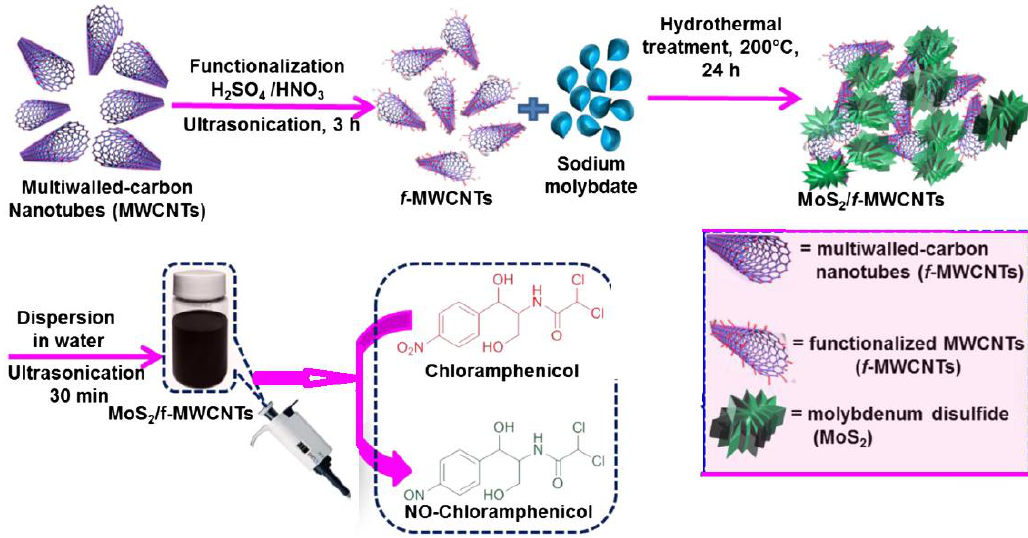
Figure 2. Effect of preparation and functionalization of MoS 2 with MWCNT (reproduced and Figure 2. E ff ect of preparation and functionalization of MoS 2 with MWCNT (reproduced and modified modified from our own publication report with copy right permission from Elesvier). from our own publication report with copy right permission from